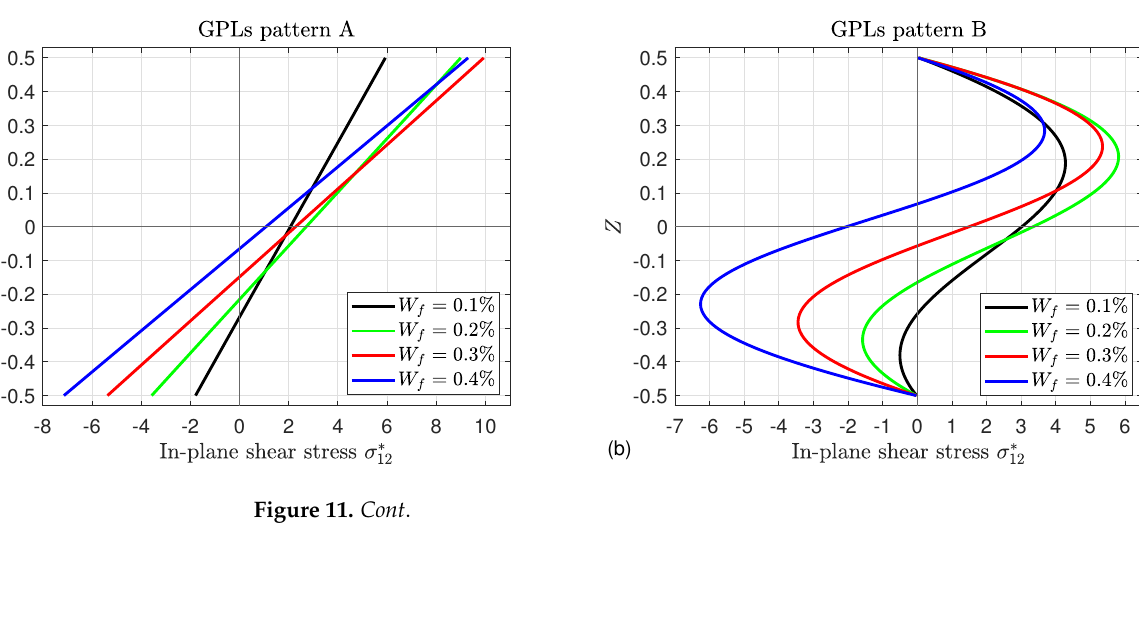
Figure 10. Influence of the GPL weight fraction W f on the transverse shear stress σ ∗ nanocomposite piezoelectric square plates for different graphene distribution patterns: ( a ) Pattern A, ( b ) Pattern B, ( c ) Pattern C and ( d ) Pattern D.